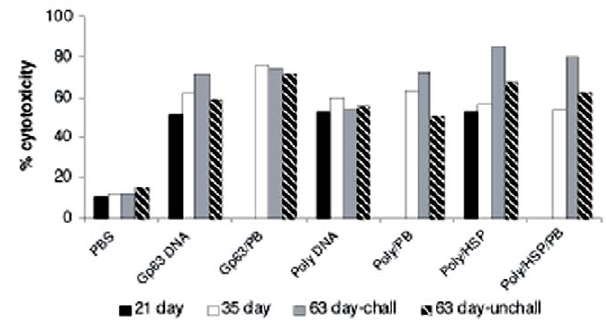
Figure 3. Percentage cytotoxicity of splenocytes isolated from various groups of immunized and control BALB/C mice. The splenocytes (Effector cells) were co-cultured with parasitized macro- phages (Target cells) and cytotoxicity was measured as LDH release by spectrophotometric analysis. Statistically significant difference was seen in all the vaccinated groups when compared with controls ( p , 0.01). The results presented here are the mean values obtained from LDH release assay performed in triplicates.